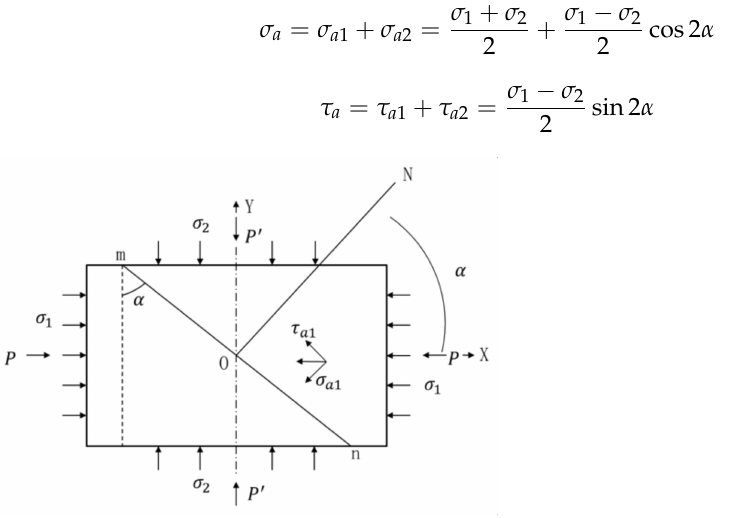
Figure 1. Principal plane stress state [25].